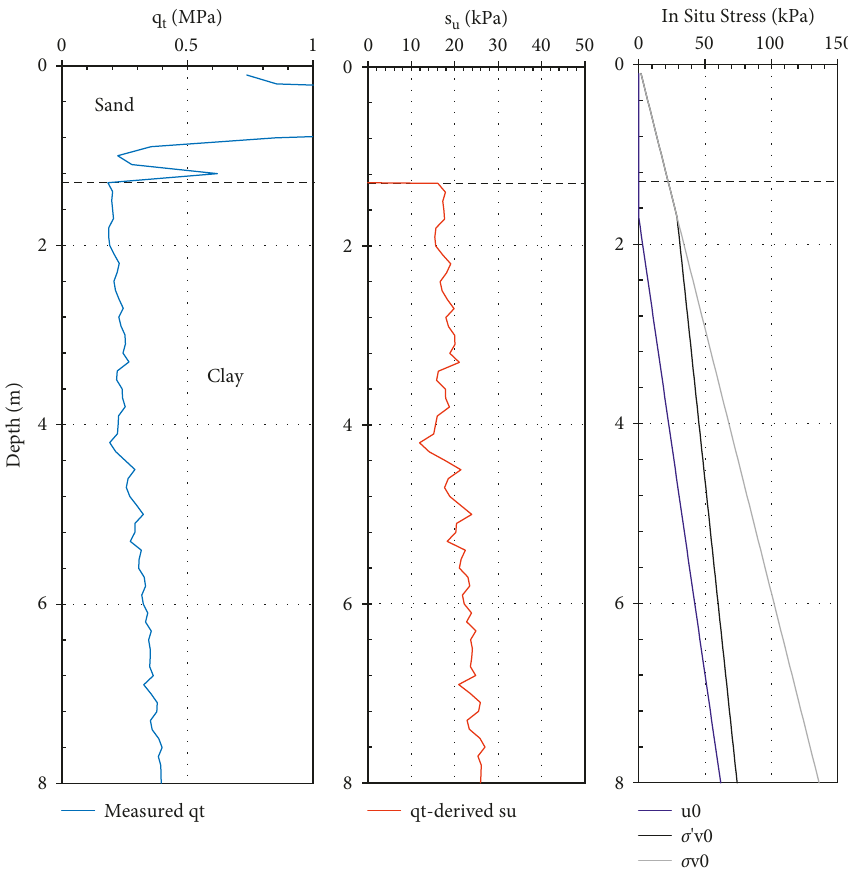
Figure 3: Profiles of cone tip resistance, undrained strength, and in situ stress.